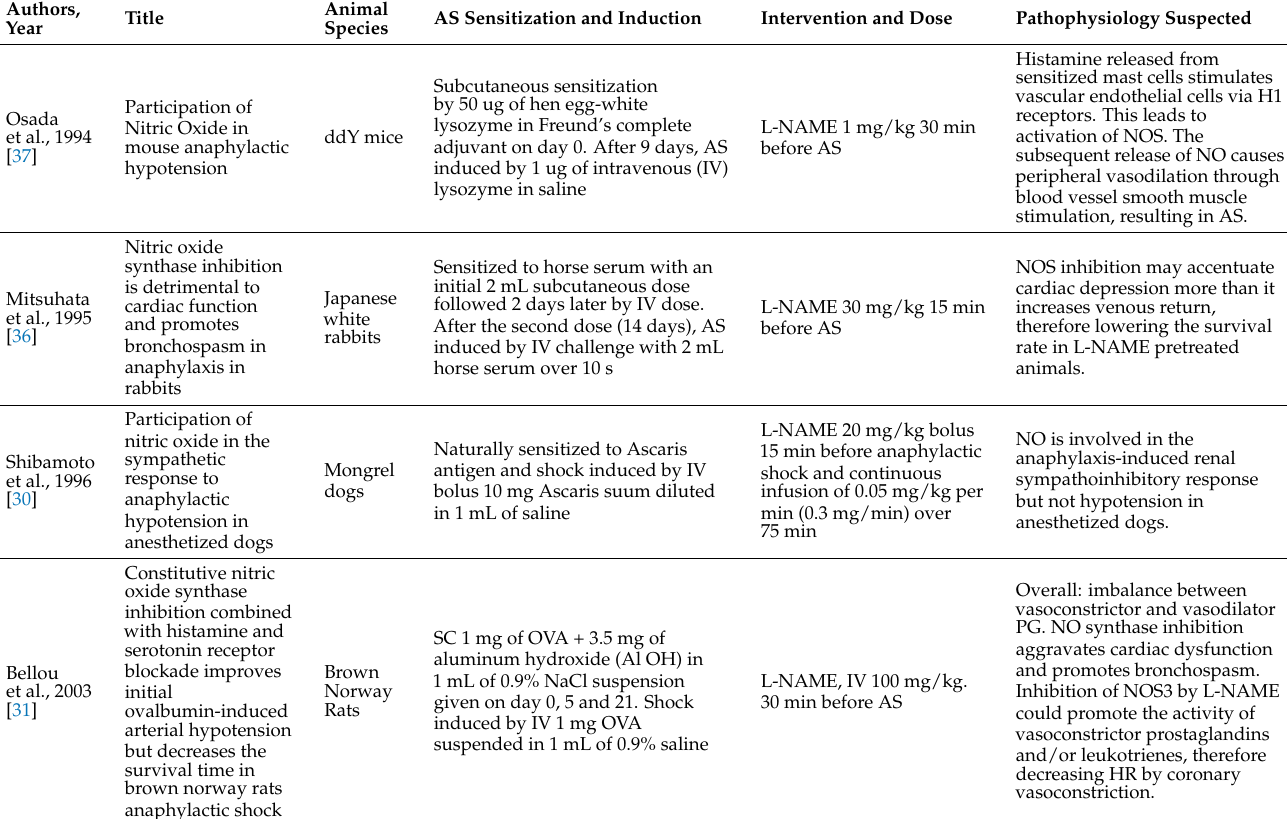
Table 1. Pre-treatment study characteristics. Aminoguanidine hydrochloride (AG) anaphylactic shock (AS), bovine serum albumin (BSA), cyclic guanosine monophosphate (cGMP), dimethyl sulfoxide (DMSO), endothelial nitric oxide synthase (eNOS), heart rate (HR), histamine (H1), indigo carmine (IC), induced nitric oxide synthase (iNOS), intraperitoneal (IP), NG-nitro-L-arginine methyl ester (L-NAME), sodium chloride (NaCl), methylene blue (MB), nitric oxide (NO), nitric oxide synthase (NOS), neuronal nitric oxide synthase (nNOS), 1H-[1,2,4] Oxadiazole [4,3-a] quinoxalin-1-one (ODQ), ovalbumin (OVA), platelet activating factor (PAF), pulmonary arterial pressure (PAP), prostaglandin (PG), phosphoinositide 3-kinase (PI3K), systemic blood pressure (SBP), subcutaneous (SC), soluble guanylyl cyclase (sGC), 7–nitroindazole